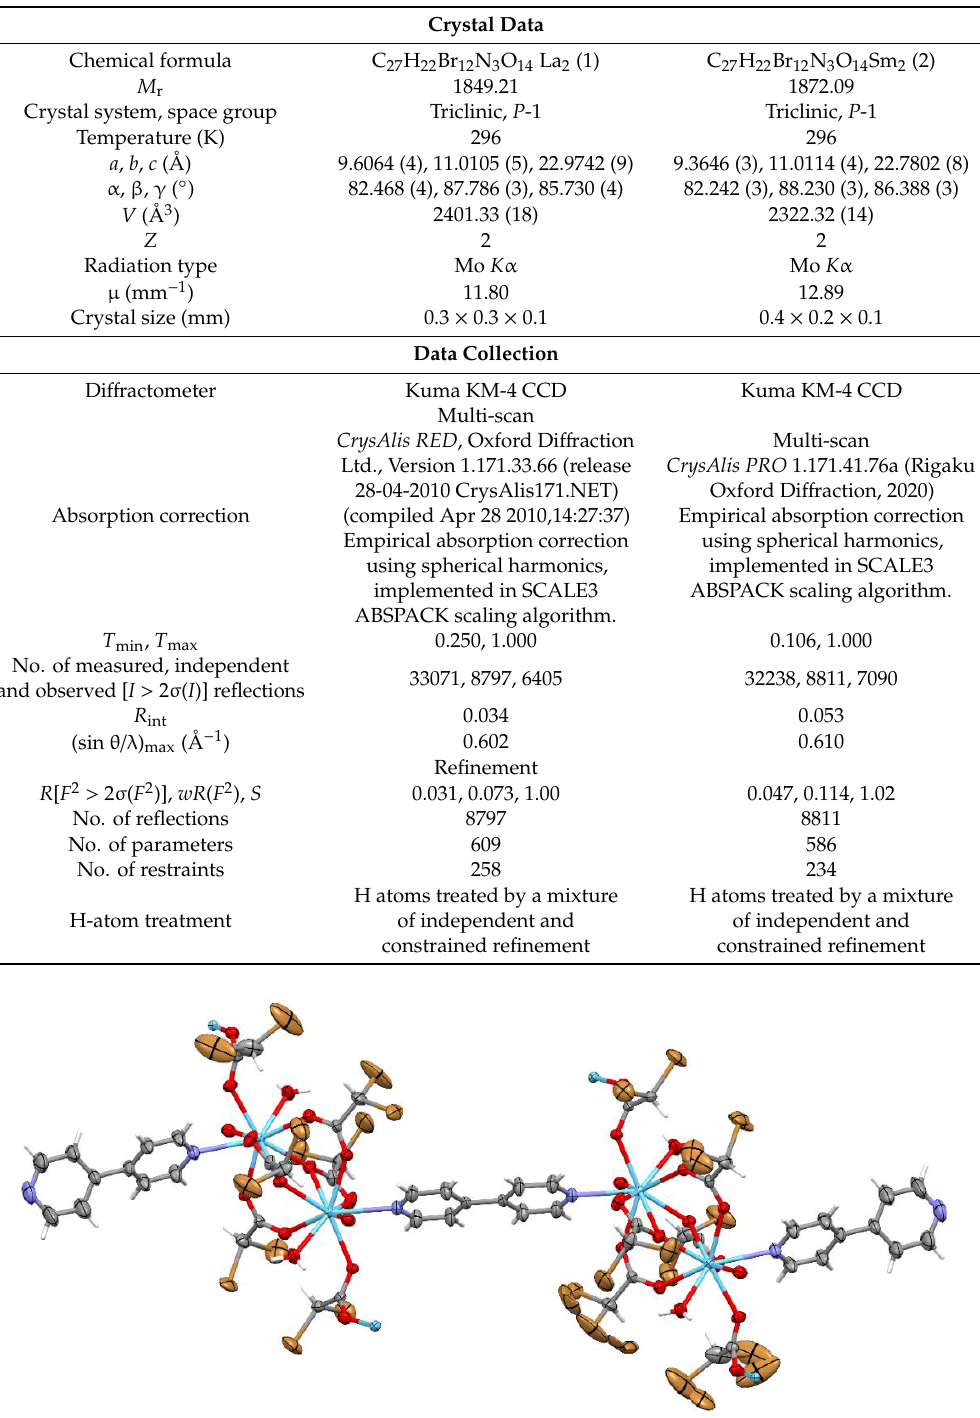
Table 2. Crystal and structure refinement data for study complexes.